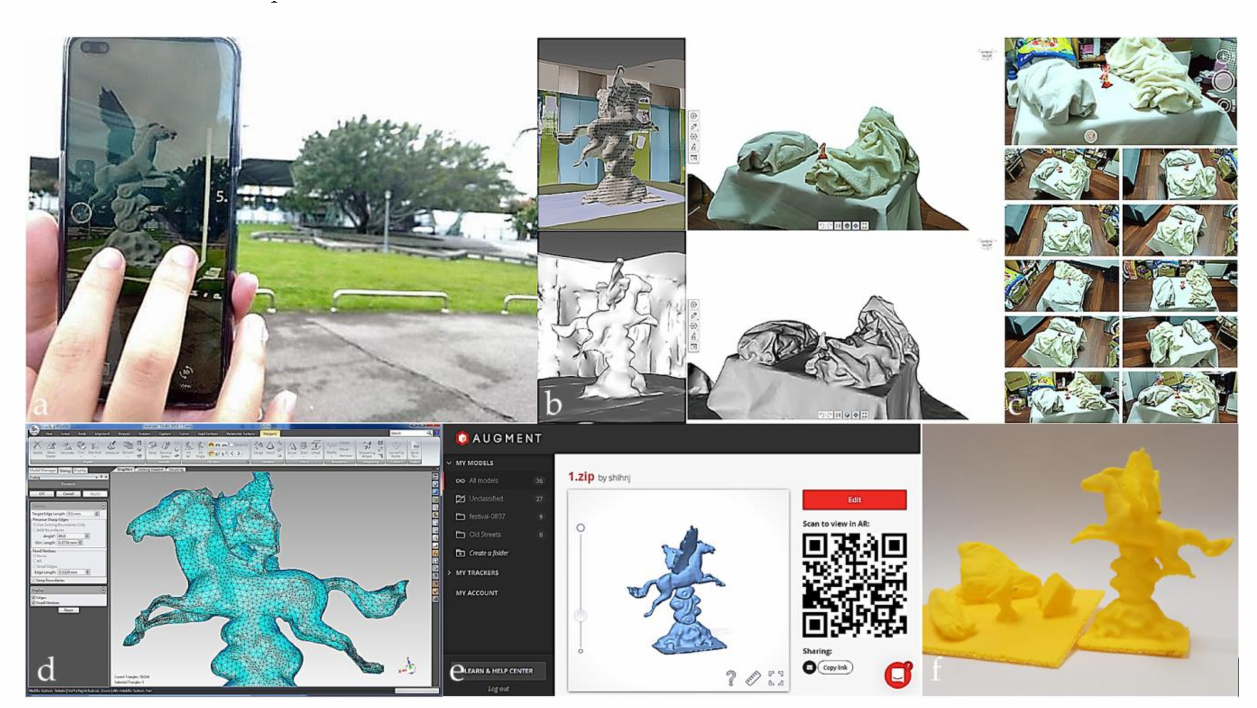
Figure 13. Reconstruction of the lantern in a new context as a sustainable preservation effort: ( a ) new allocated setting with the surrounding context; ( b ) photogrammetry modeling case 1; ( c ) modeling of case 2 made by the screenshots taken from the AR scenes; ( d ) the modification process; ( e ) AR QR code of the model; ( f ) 3D-printed model and layout case made by reversed